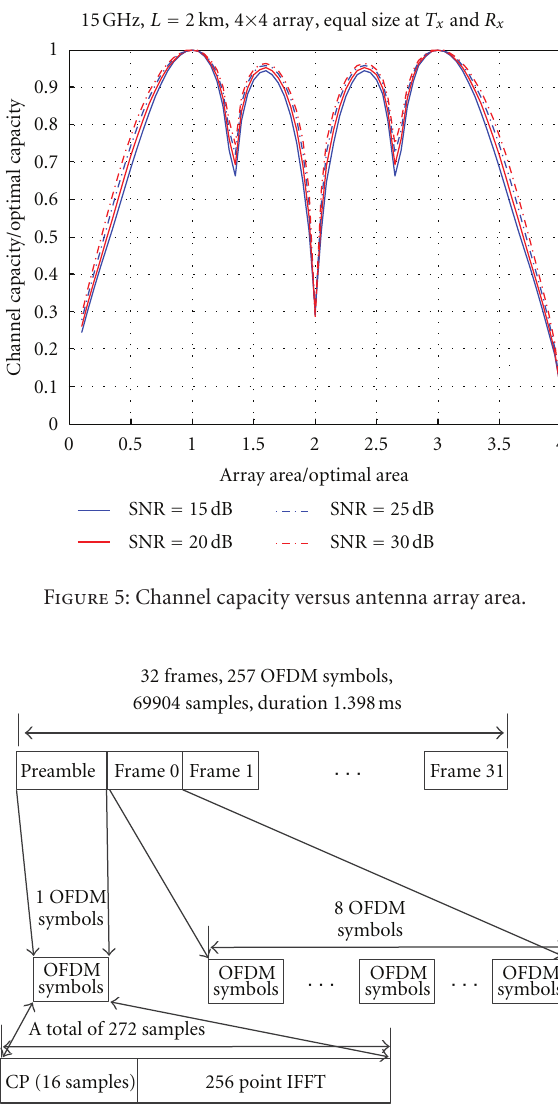
Figure 6: Frame structure of one super frame.